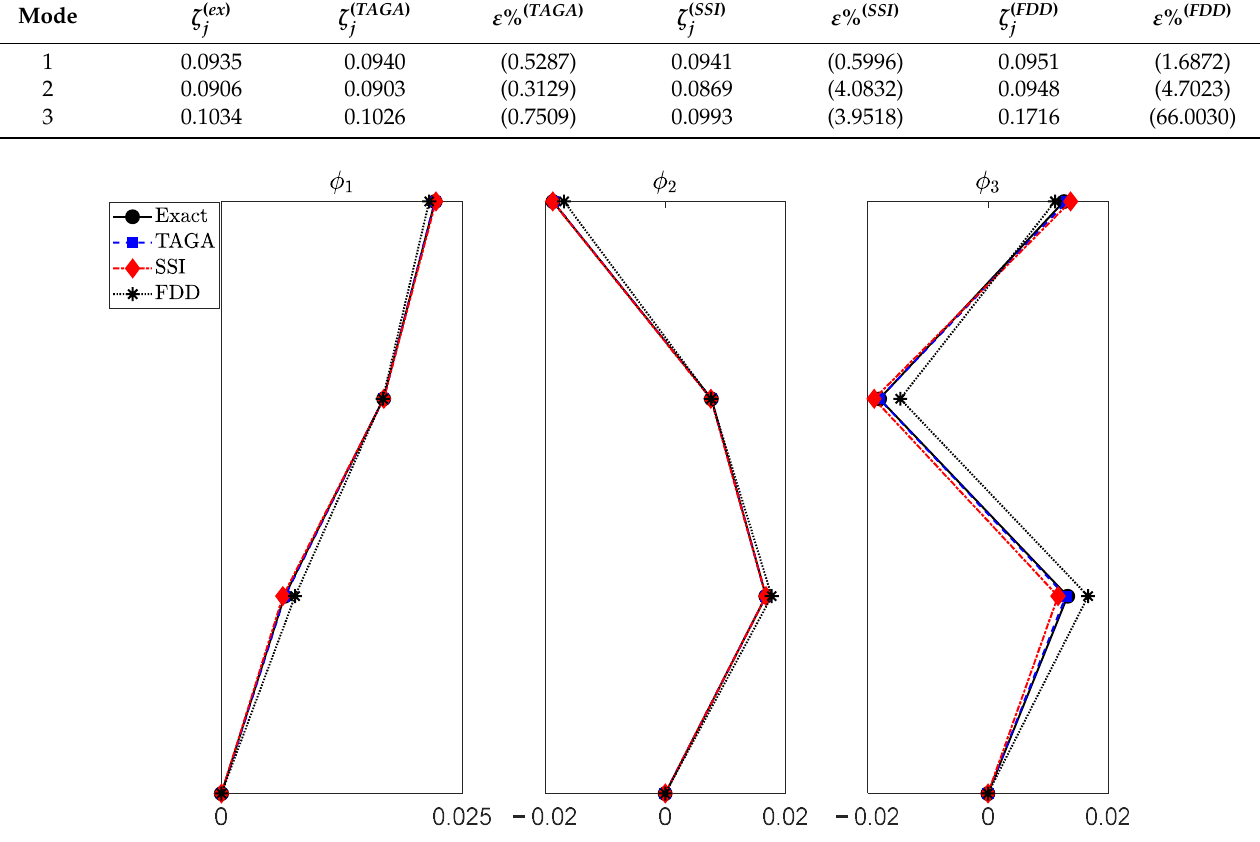
Table 5. Discrepancy between the estimated FRFs matrix in nodal space and the exact one for the 3DoF